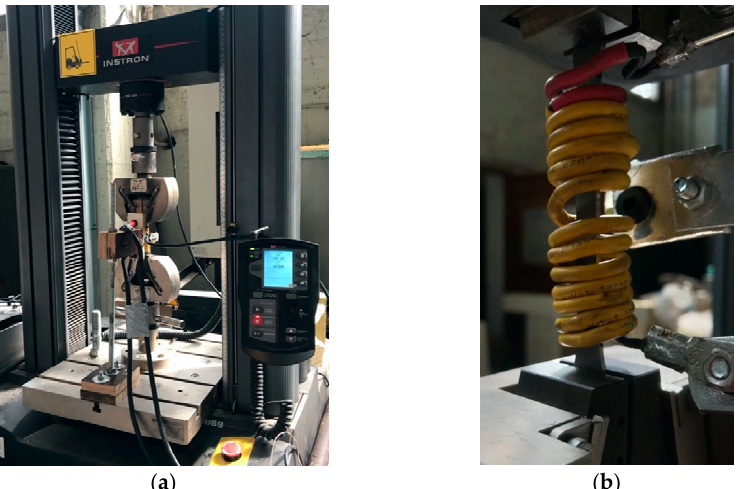
Figure 5. ( a ) Instron 596 tensile testing equipment; and ( b ) specimen heating coil, part of the induc- tion heating machine. heating